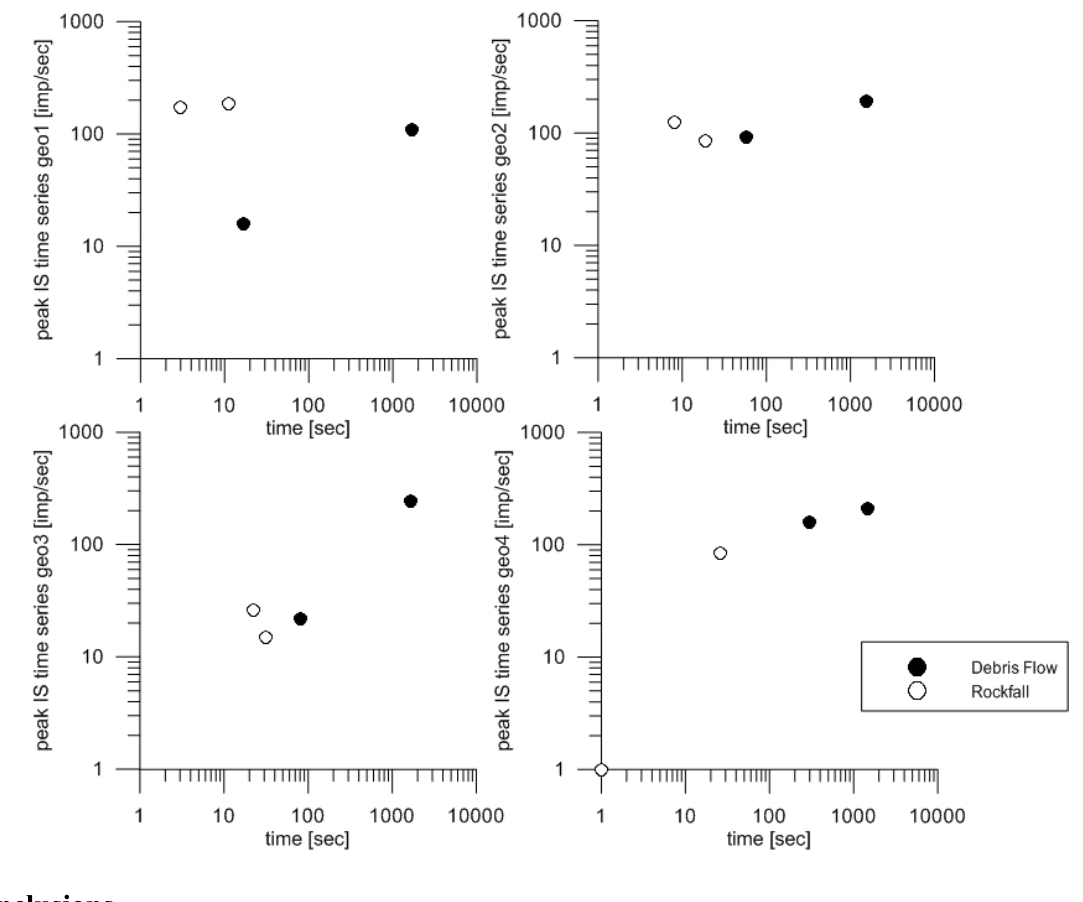
Figure 11. Distinction of processes in Rebaixader by using two parameters: the sum of seconds with registered impulses from the geophone and the peak value of the IS time